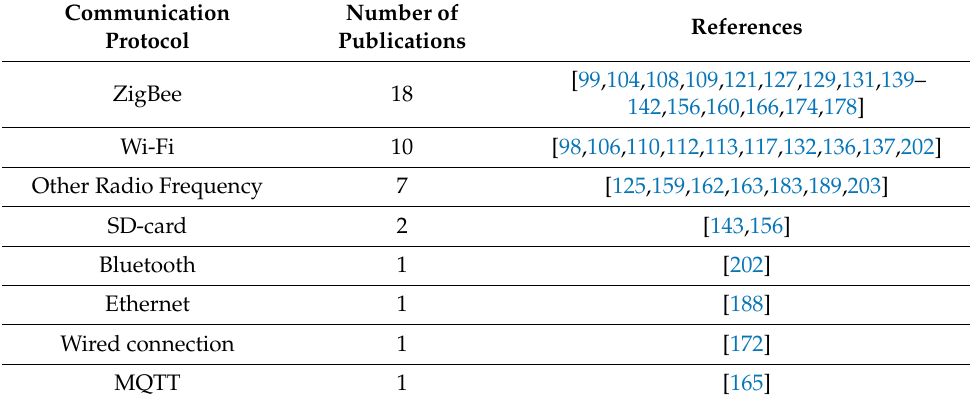
Table 5. Group of communication protocols was used in SCOPUS database for low-cost building